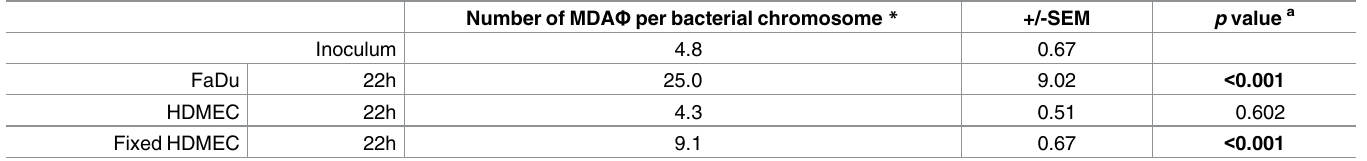
Table 1. Quantification by real time PCR of the number of MDA Φ DNA per bacterial